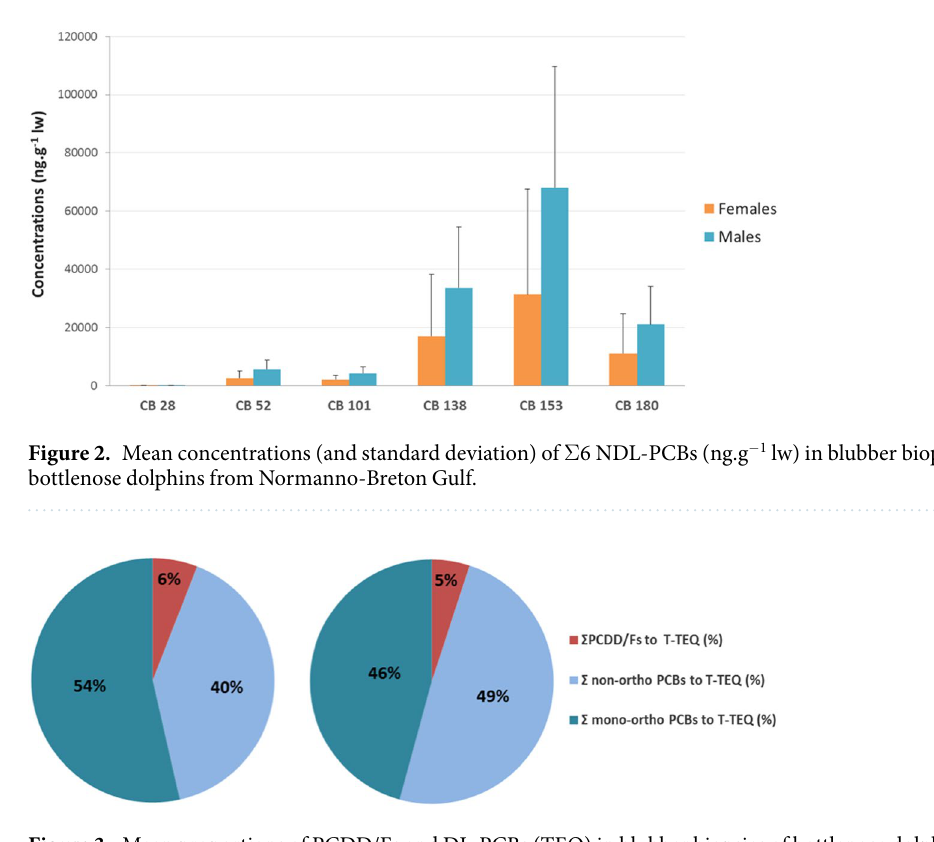
Figure 3. Mean proportions of PCDD/Fs and DL-PCBs (TEQ) in blubber biopsies of bottlenose dolphins from the Normanno-Breton Gulf in males (left) and females